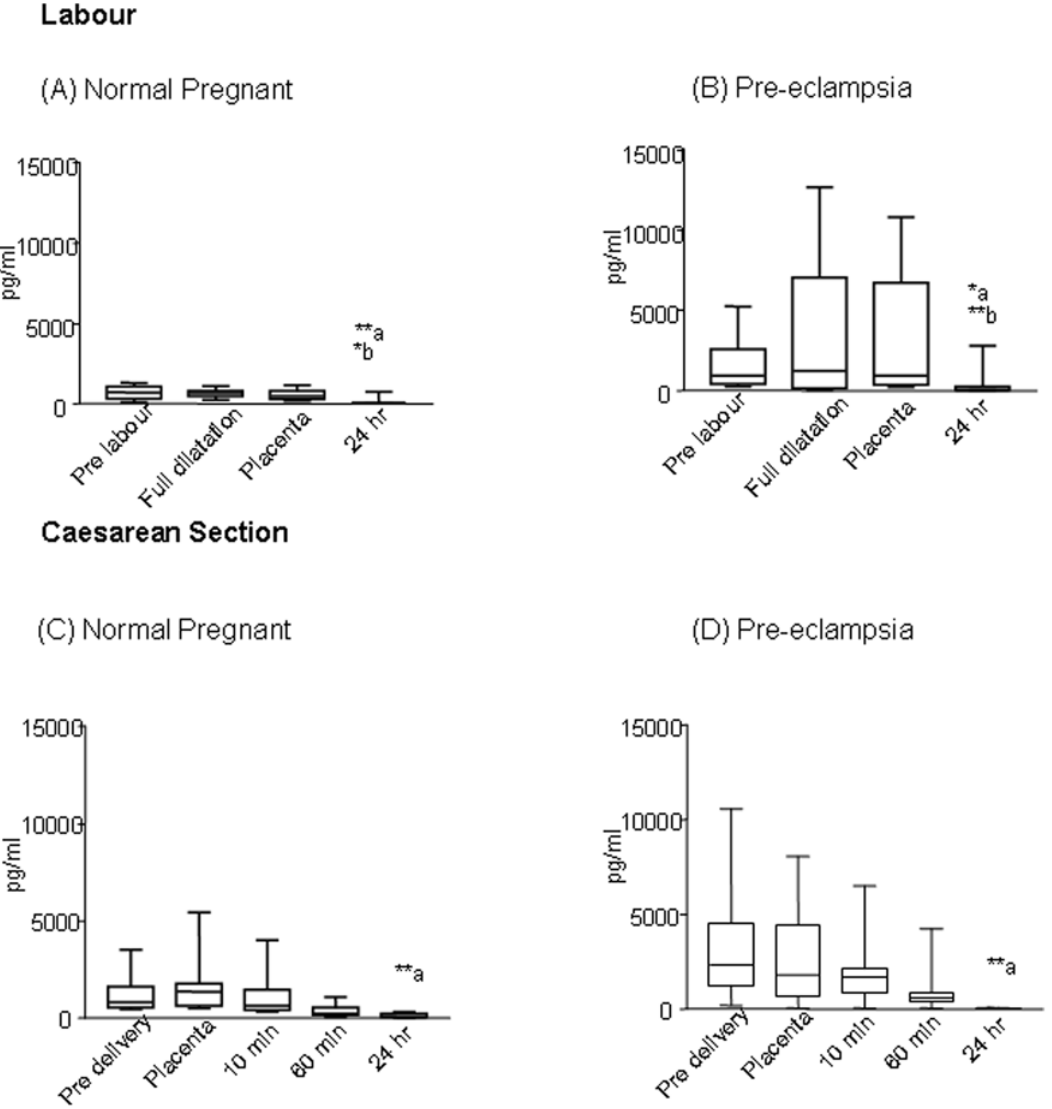
Figure 2. Inhibin A levels (n=10) in maternal plasma during labour and Caesarean section. Median and ranges for inhibin A levels pg/ml in labour (A, B). In normal pregnancy labour (A) there was a significant decline in inhibin A levels by 24 h (a**p , 0.01-prelabour vs 24 hr, full dilatation vs 24 hr, and b* p , 0.05-placental delivery vs 24 hr. A similar decline was present in PE labour (B) (a*p , 0.05, a-pre-labour vs 24 hr, b **p , 0.01- placental delivery vs 24 hr), but the increase noted between pre-labour and full dilatation in pre-eclamptic women was not significant. At Caesarean section (C,D) a significant decline in levels of inhibin A by 24 hr was noted with placental delivery. (NP and PE a**p , 0.01 placental delivery vs 24 hr).